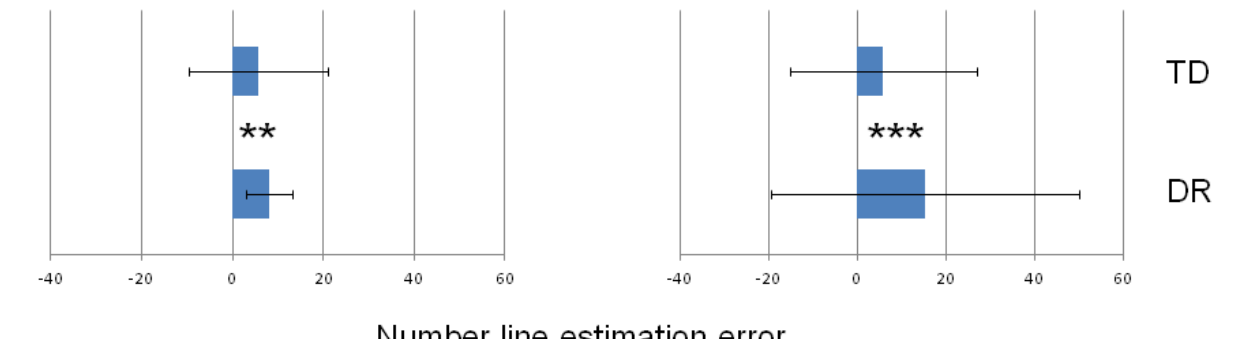
Figure 4. Estimation error (EE; median values represented by bars) obtained in the DR and TD groups in the number-to-position task with the use of 0–100 number line ( left ) and 0–1000 number line ( right ). The error bars represent the interquartile range (IQR) values. ** p < 0.01; *** p < 0.001 Table 2 . Descriptive statistics (median, IQR, and range) calculated for all numbers used in tasks 3 and 4 (0 – 100 and 0 – 1000, respectively) obtained in the DR and TD groups.